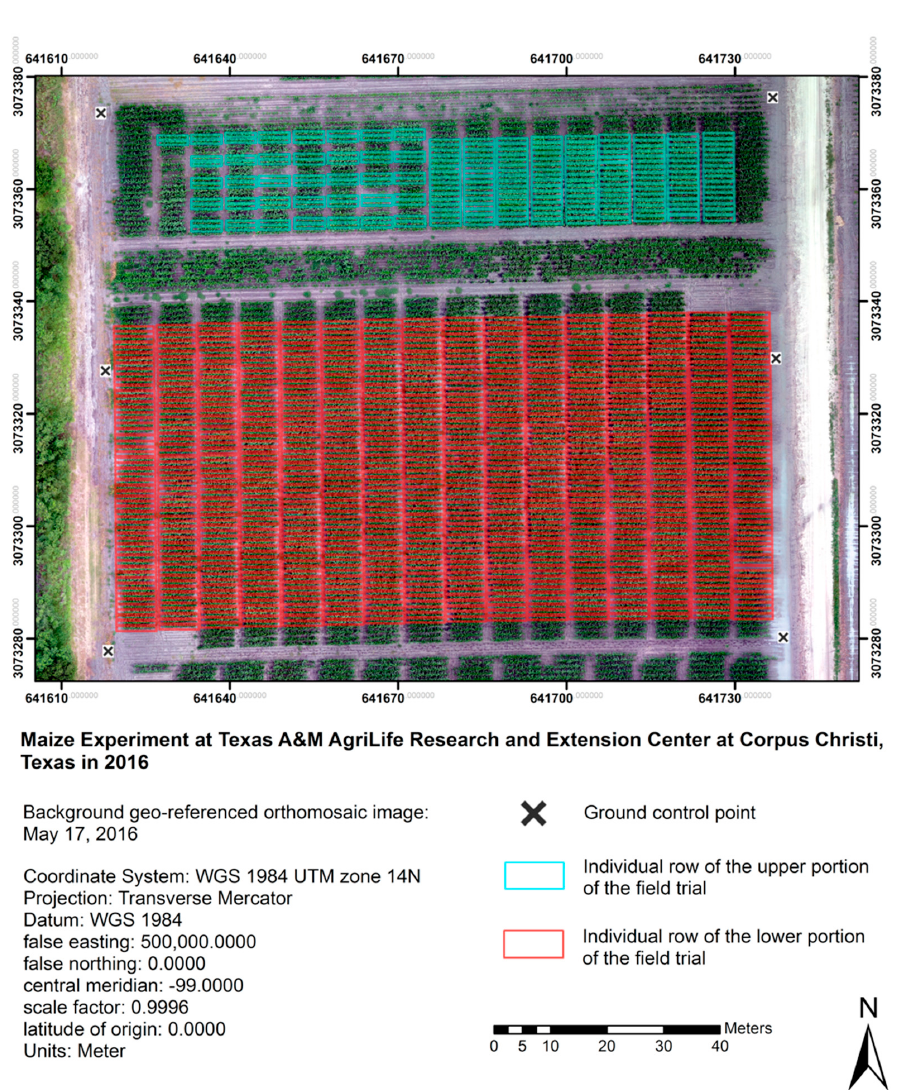
Figure 1. Maize field trial established at the Texas A&M AgriLife Research and Extension Center in Corpus Christi, TX,